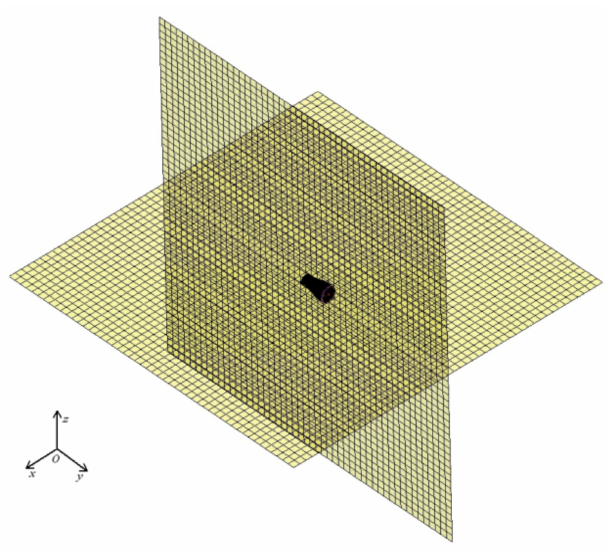
Figure 8. Acoustic model of the ring-stiffened conical